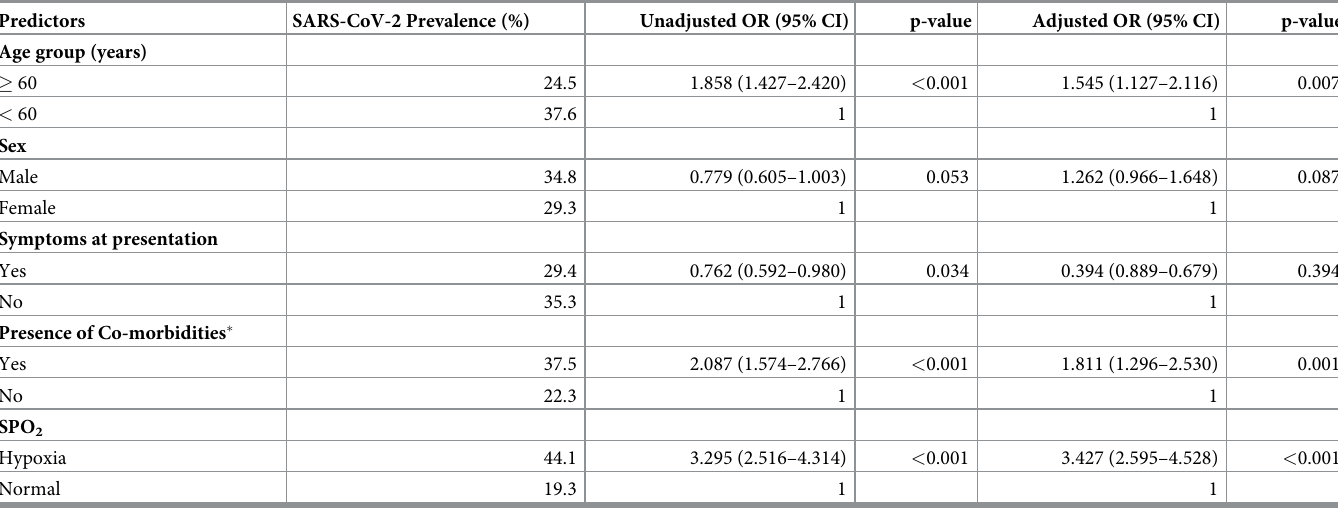
Table 3. Unadjusted and adjusted logistic regression model for determinants of a positive RT-PCR for SARS-CoV-2 result.